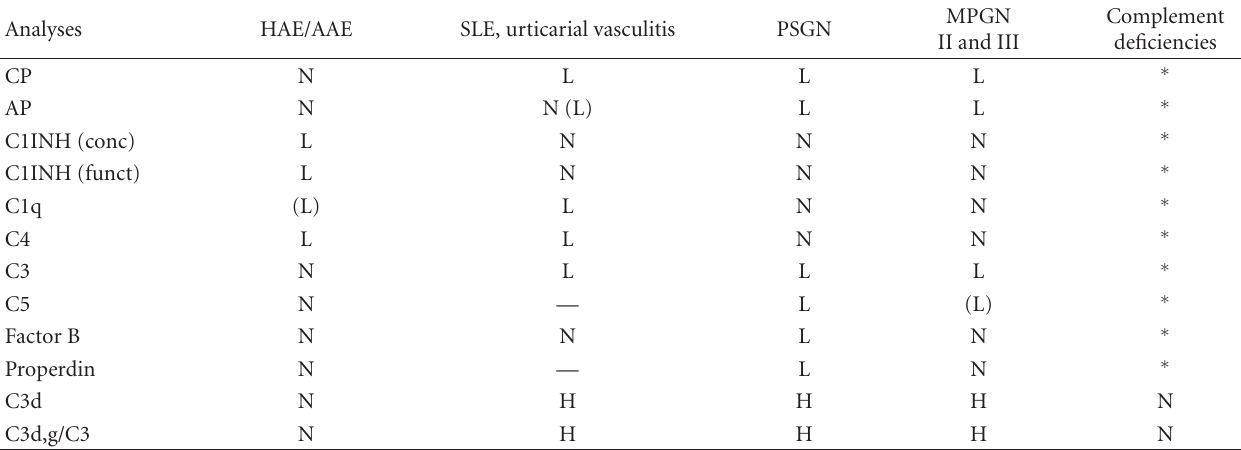
Table 2: Complement pathology, di ff erential